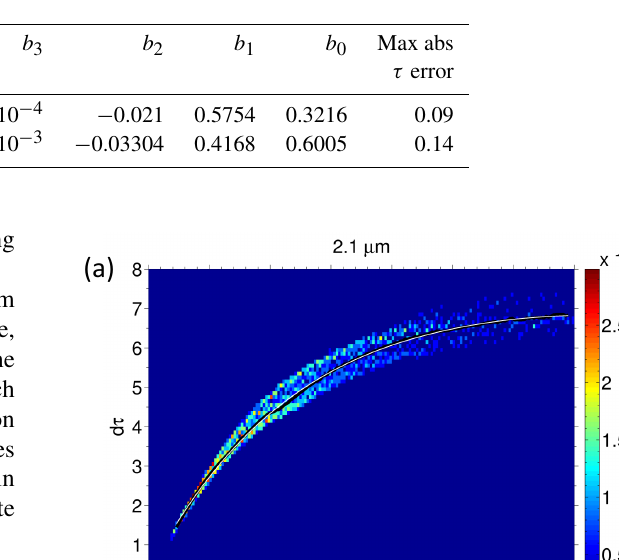
Table 2. Coefficients for the fitting curve (Eq. 15) to estimate the mean d τ value as a function of τ . The maximum absolute error between the fit and the mean line is also shown.